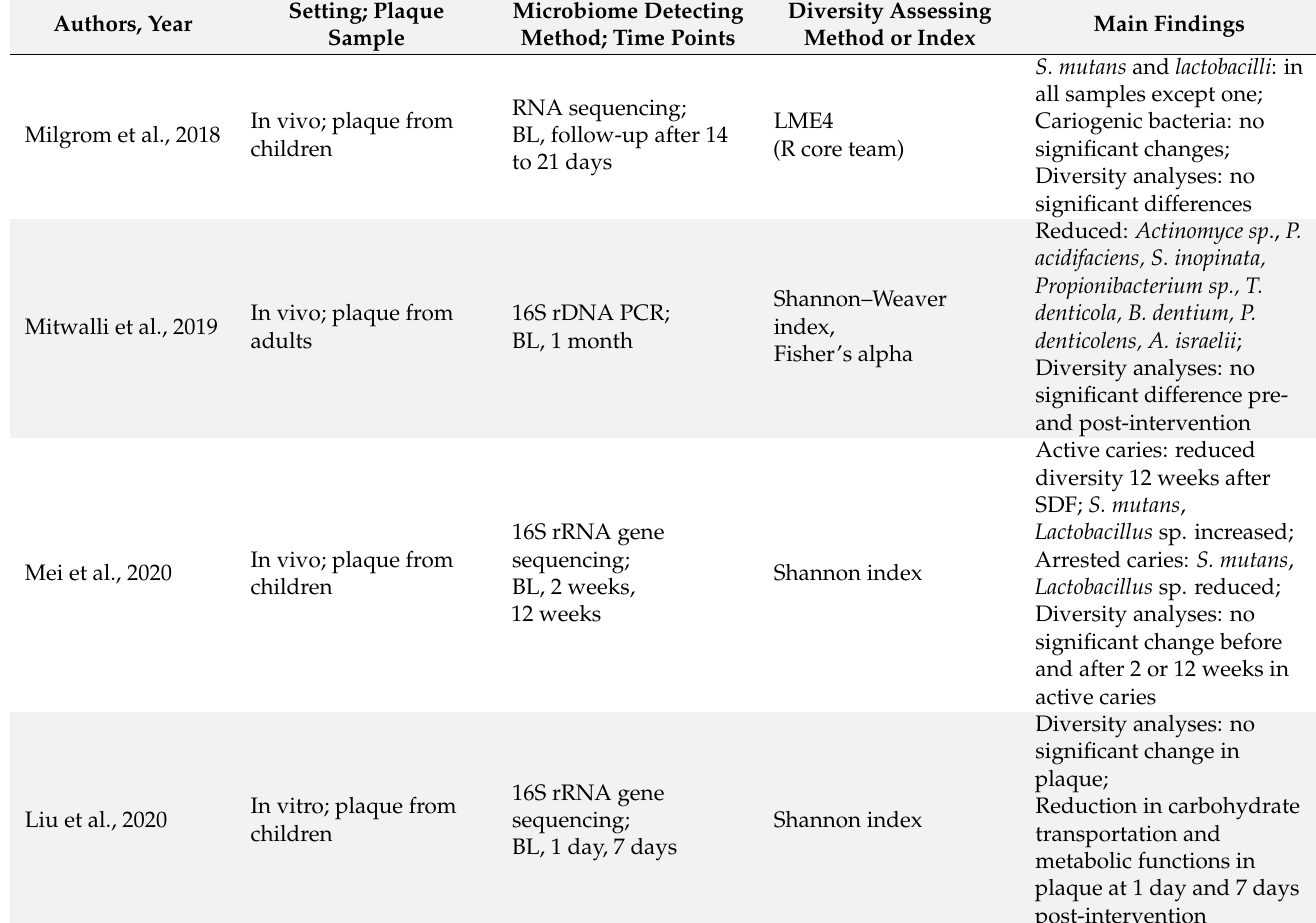
Table 2. Microbiota change within biofilm after silver diamine fluoride